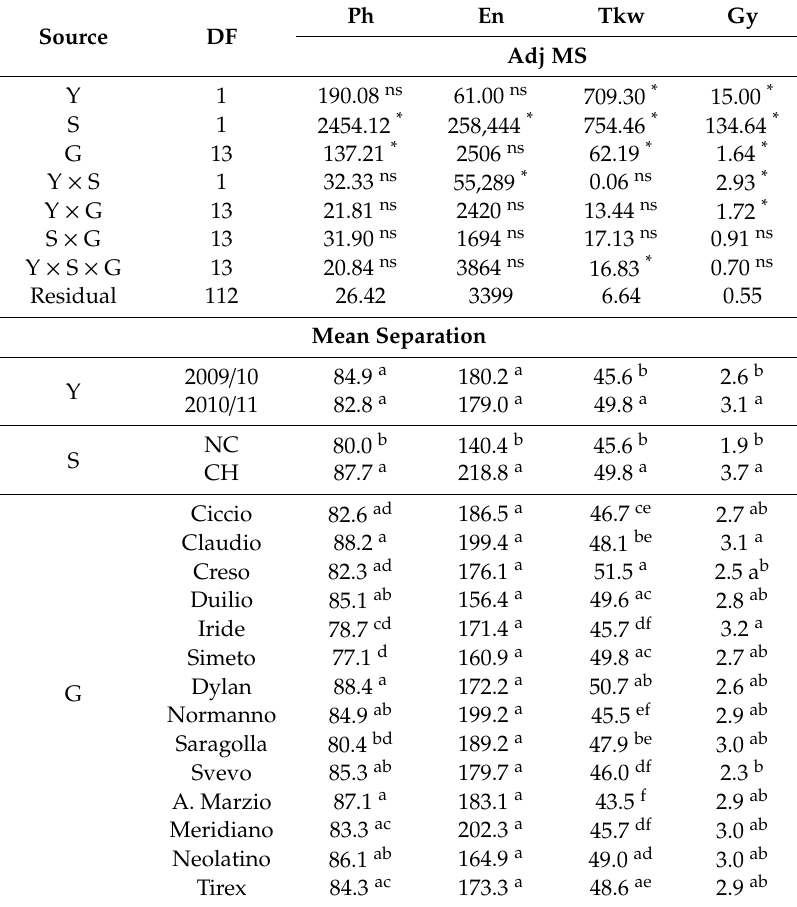
Table 3. ANOVA for morphological (Plant height—Ph), and productive traits (ears m − 2 —En, thousand kernel weights-Tkw, grain yield-Gy) of durum wheat genotypes grown under two management systems in two growing seasons. Degree of freedom; adjusted mean square; and significant per p ≤ 0.05 (*), Not significant (ns). Di ff erent letters within columns stand for significant mean according to the SNK test ( p ≤